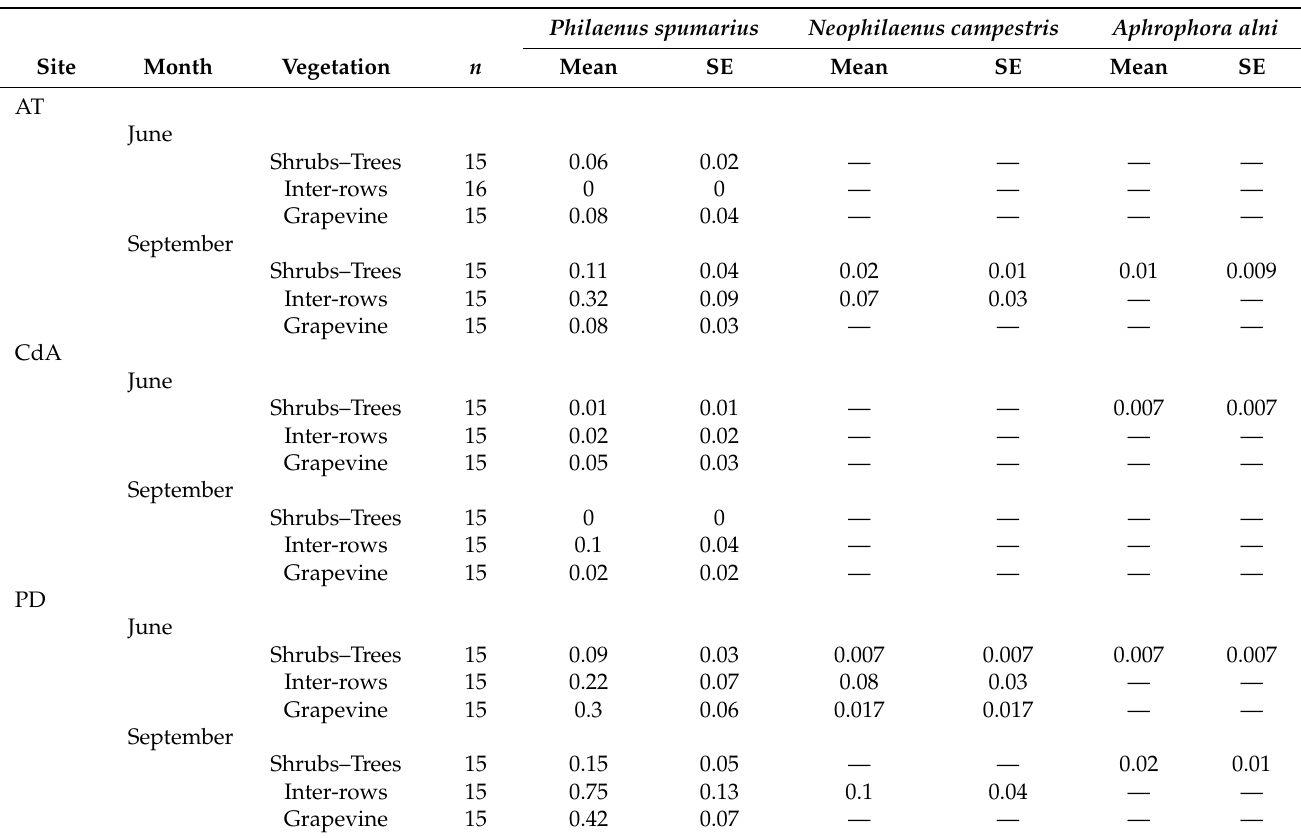
Table 4. Abundance of spittlebug adults (mean individuals/sweep) on different vegetation compartments in June and September in three organic Piedmont vineyards (AT = Asti, CdA = Cisterna d’Asti, PD = Paderna) in